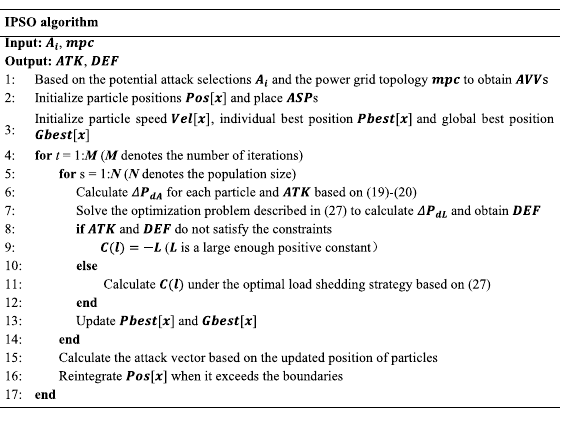
TABLE 2 Procedure of the proposed IPSO